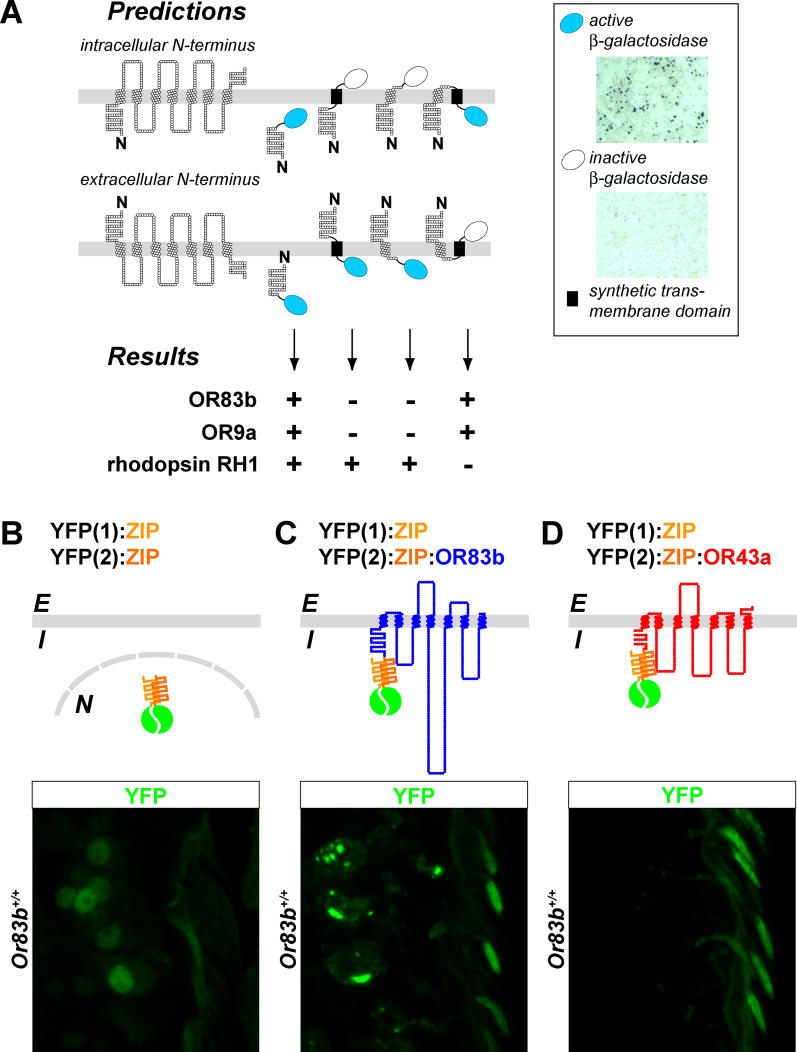
The N-Terminus of Drosophila ORs Is Intracellular(A) Determination of OR N-terminus membrane insertion orientation by the β-gal fusion technique in S2 cells. Top left bars: schematic of fusion constructs and predictions of β-gal activity for proteins with an intracellular or extracellular N-terminus. Top right panels: sample field of view of S2 cells expressing OR83b N-term: β-gal (top panel) and OR83b N-term:artificial TM domain: β-gal (bottom panel) stained with X-gal to reveal active and inactive β-gal. Bottom table: active (+) and inactive (−) β-gal in the indicated OR83b, OR9a, and Drosophila RH1 fusion proteins.(B–D) Intrinsic YFP fluorescence (green) in antennal sections of animals expressing the indicated combinations of complementary YFP fragment and ZIP dimerization domain fusions with these genotypes:(B) Or83b-Gal4/+;UAS-YFP(1):zip/UAS-YFP(2):zip
(C) Or83b-Gal4/UAS-YFP(2):zip:Or83b;UAS-YFP(1):zip/+
(D) Or83b-Gal4/+;UAS-YFP(1):zip/UAS-YFP(2):zip:Or43a